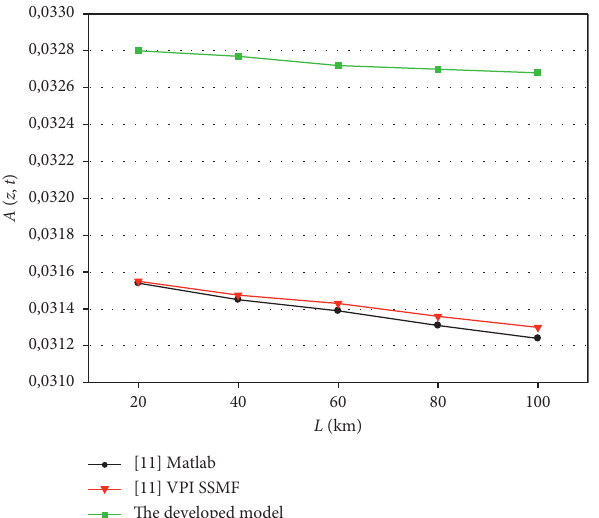
Figure 11: Variation of output signal amplitudes variation at different values of optical fiber length.